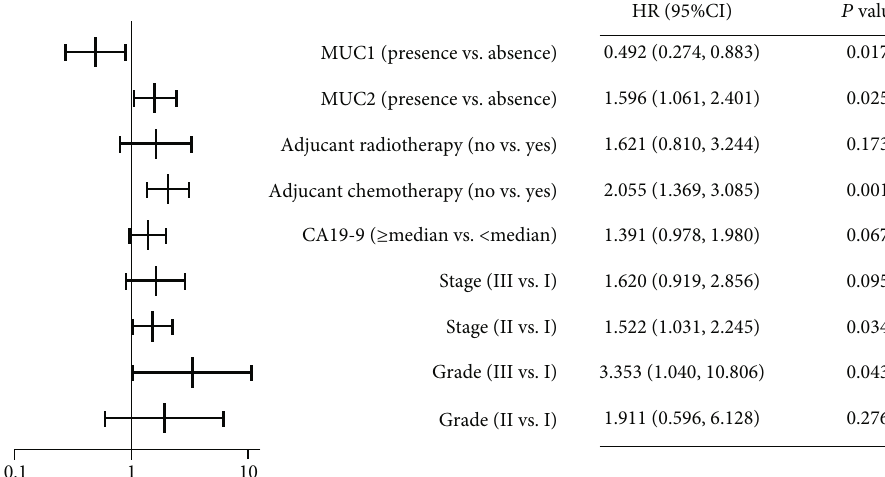
Figure 3: Multivariate analyses of mucin expression and clinicopathological characteristics on overall survival. The univariate analysis results of the FUSCC cohort are displayed in Supplementary Table 2, and risk factors with a p value less than 0.1 in the univariate analysis were integrated to make multivariate logistic regression. The X -axis of this forest plot stands for HR, which was calculated by logistic Cox regression, enter method. The median of CA19-9 was 188.6U/ml. Abbreviations: HR: hazard ratio; CI: con fi dence interval.